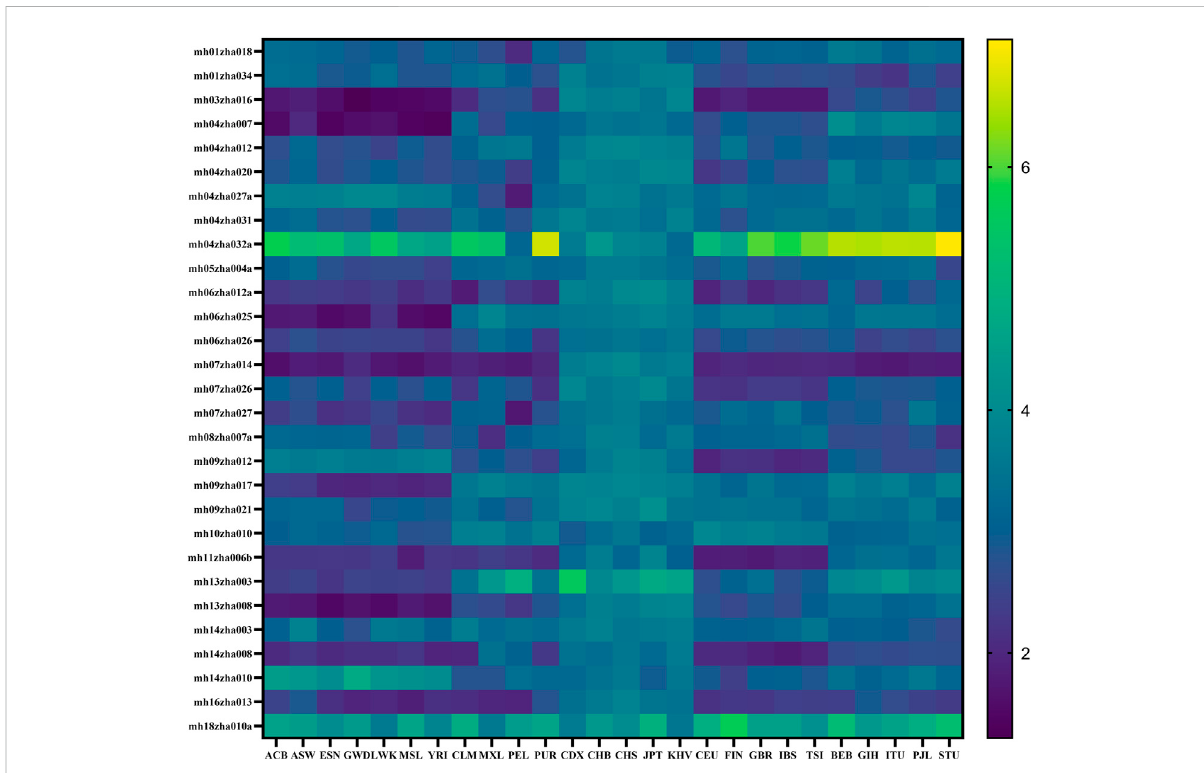
FIGURE 1 The heatmap of A e distribution of 29 microhaplotype loci in 26 populations based on the data of the 1000 Genomes Project.